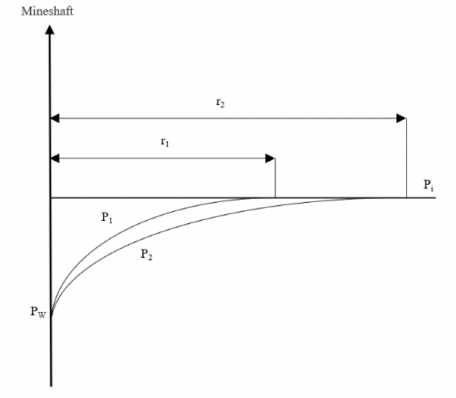
Figure 2. Reservoir pressure distribution before pressure arrived at the outer